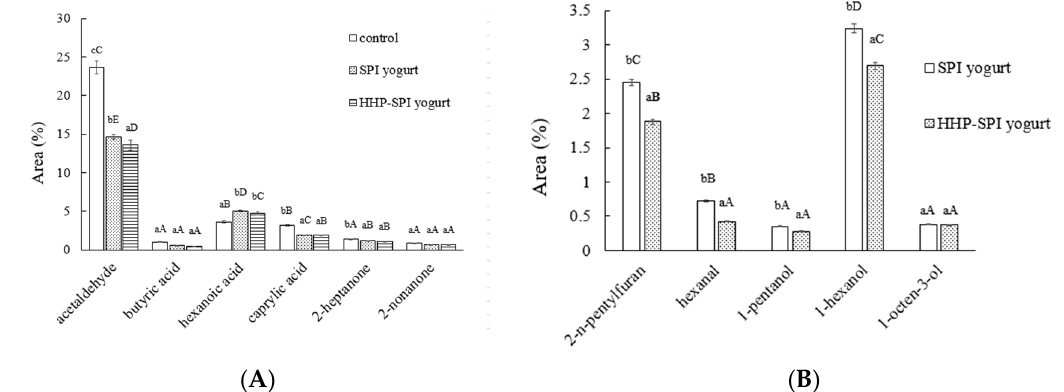
Figure 5. The volatile compounds of yogurt without SPI (control), or with SPI and HHP-SPI: ( A ) beany flavor components; ( B ) acetaldehyde, acid, and ketone components. Capital letters: statistical significance between groups; lowercase letters: statistical significance in the groups.